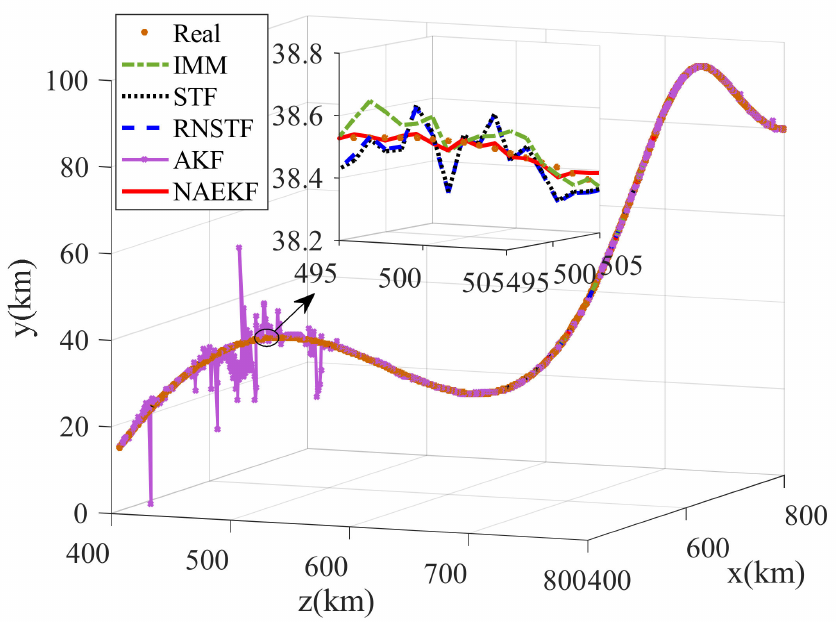
Figure 5. Estimated